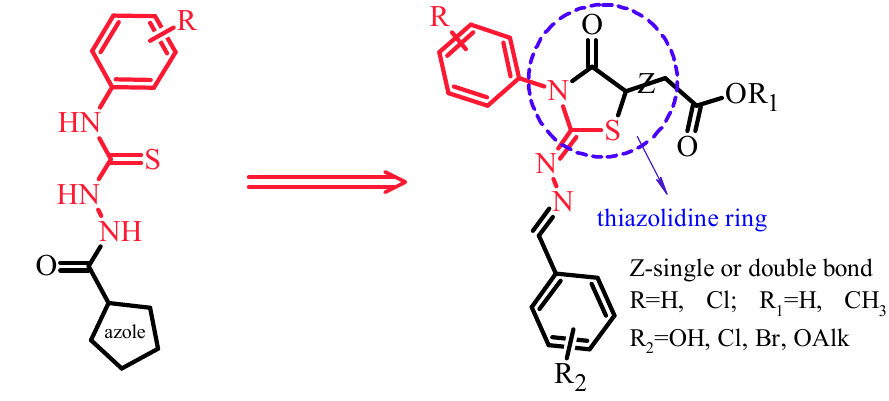
Figure 1. Design of novel thiazolidin-4-one derivatives .